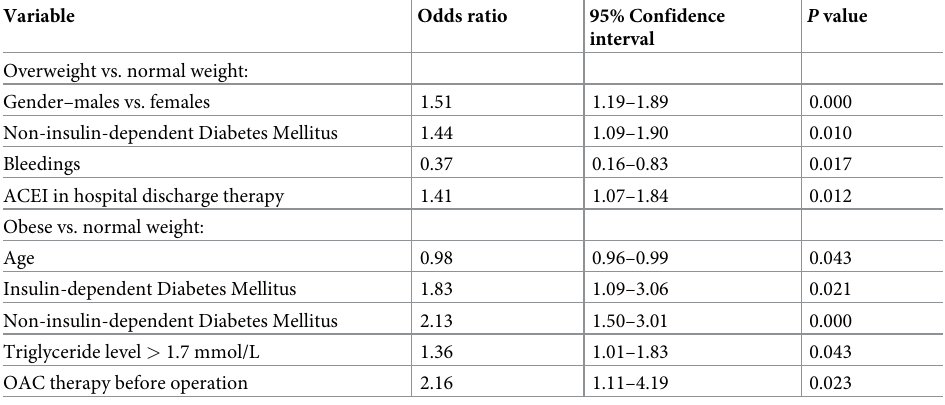
P value interval